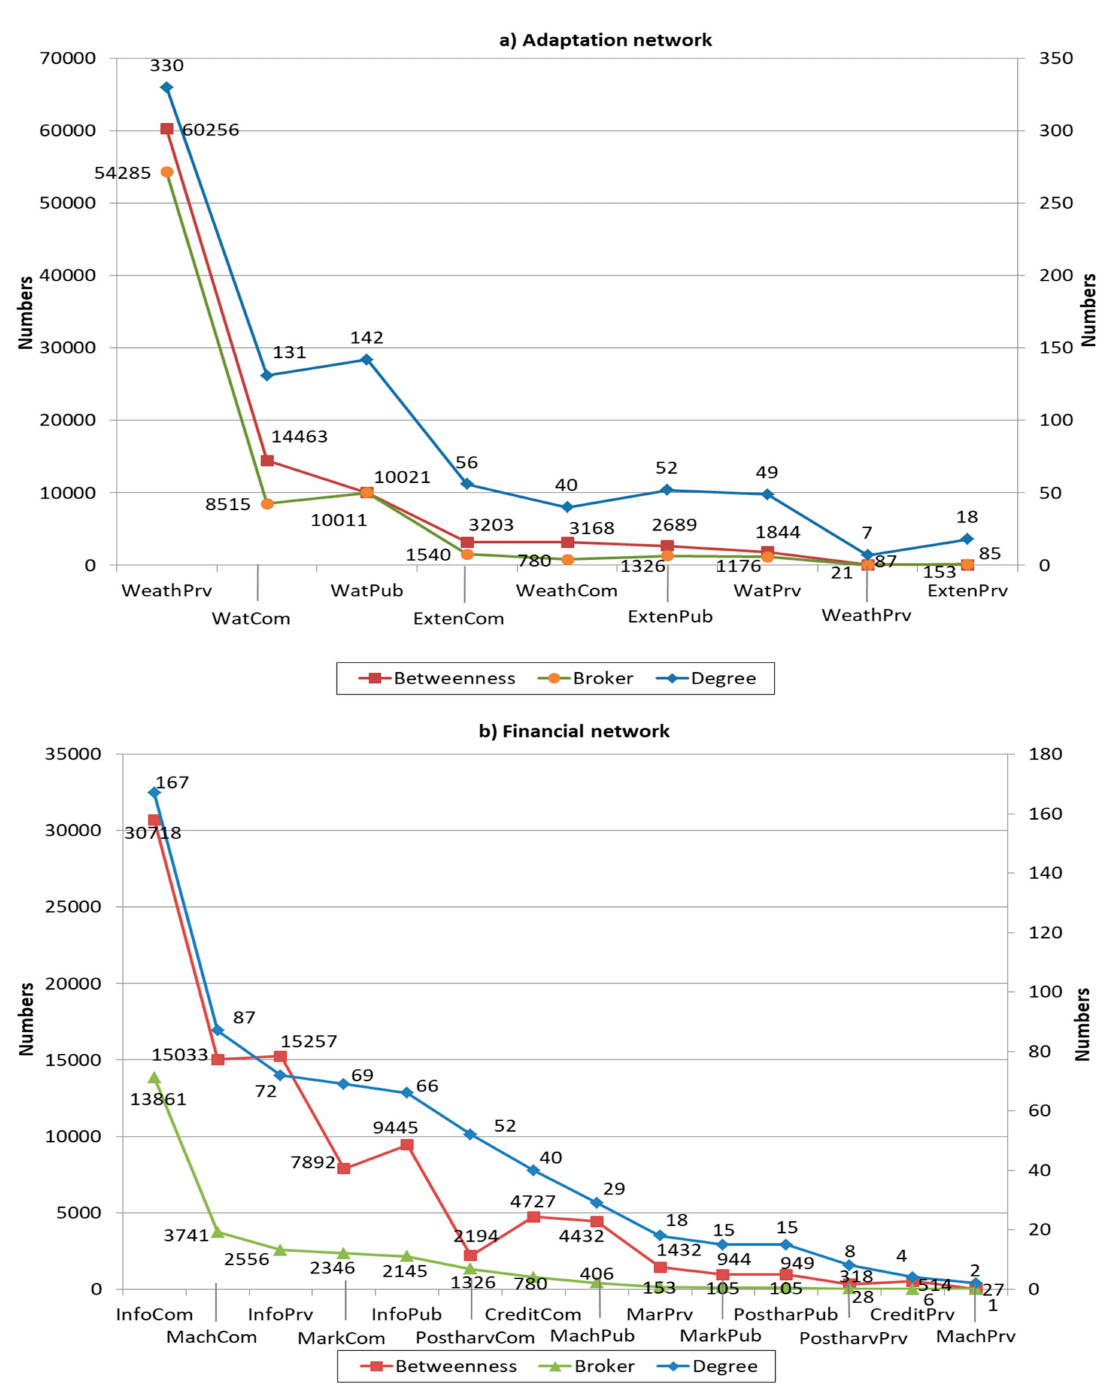
Figure 6. ( a , b ) Structural gaps in the current institutional support to climate adaptation. The red lines show the betweenness between farmers and different institutional factors that count the number of network pathways passing through an actor, the green lines show the broker linkages which indicate how much potential control an actor has in spreading information or providing services in a social network and the blue lines (on secondary vertical axis) indicates the degree of different factors showing the absolute number of connections of each factor with farmers from all